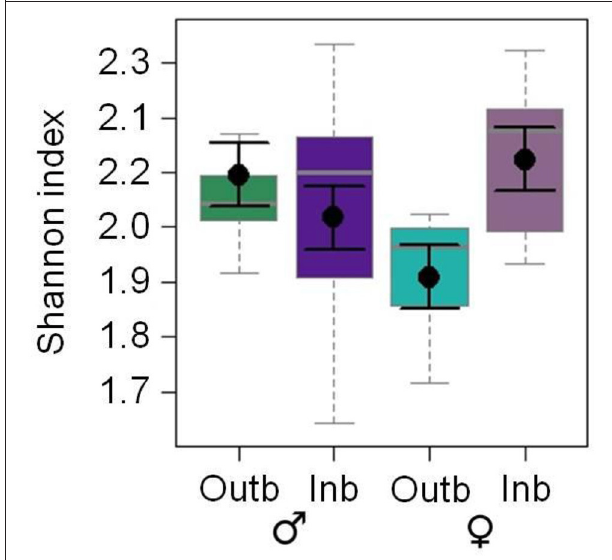
FIGURE 2 | Effects of the factor breeding status [outbred (Outb; green) and inbred (Inb; purple)] and sex [males (dark) and females (light)] on the Shannon index of putative cuticular hydrocarbons of adult Phaedon cochleariae ( N = 9–10 adults per breeding status and sex; analyzed with a LM). The box-whisker plots show the medians (solid gray lines), interquartile ranges (boxes), 1.5 * lower/upper quartiles (whiskers) and least square means with their standard errors (black dots with error bars) extracted from the minimal adequate LM. One outlier above 2.5 for the outbred males is not shown in the figure but was included in the statistical analysis.